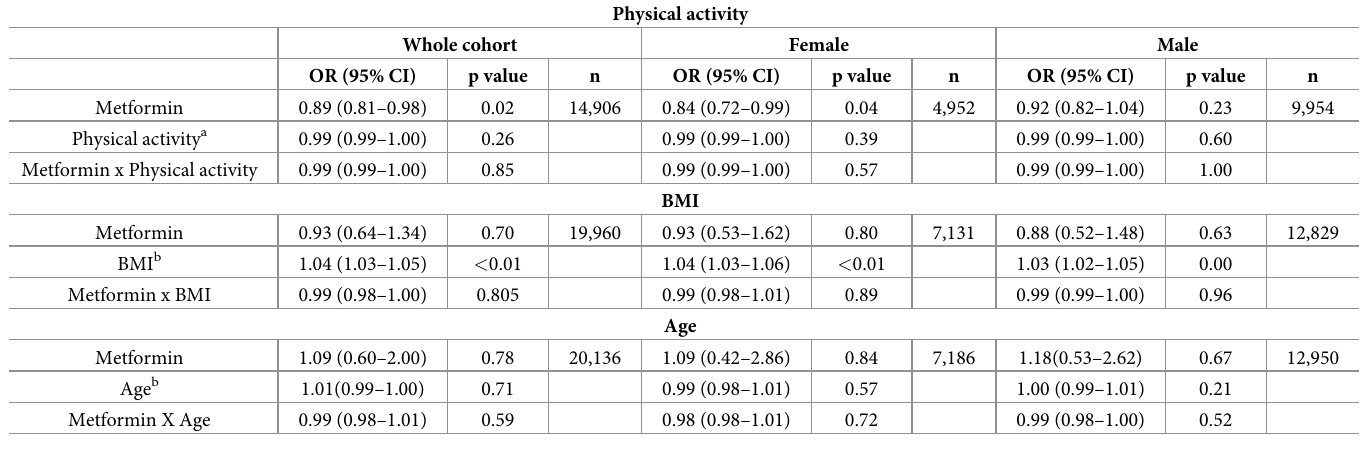
Table 5. Association between metformin and back pain considering the interaction between metformin and physical activity levels, BMI and